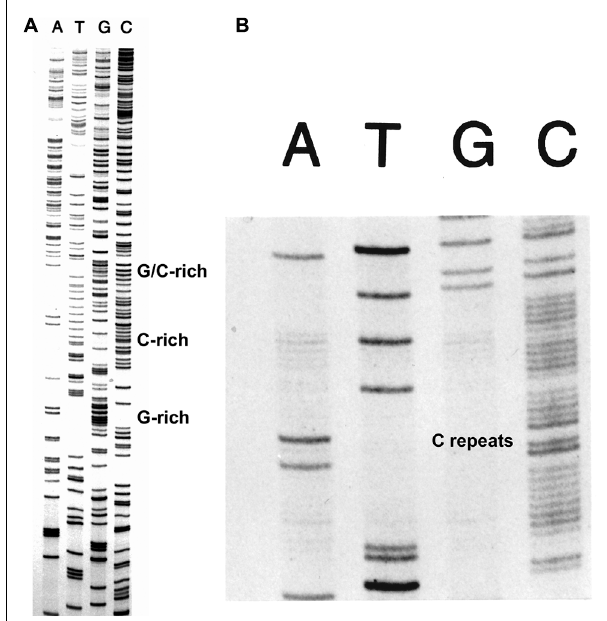
FIGURE 5 | Sequencing difficult DNAs with FIDELITY TM . The combination of the exonuclease-deficient L412M-DNA polymerase, theT4 clamp and clamp loading proteins, and theT4 single-stranded DNA binding protein provides the means to sequence difficult DNAs with high G + C content (A) and tracks of mononucleotide repeats (B)